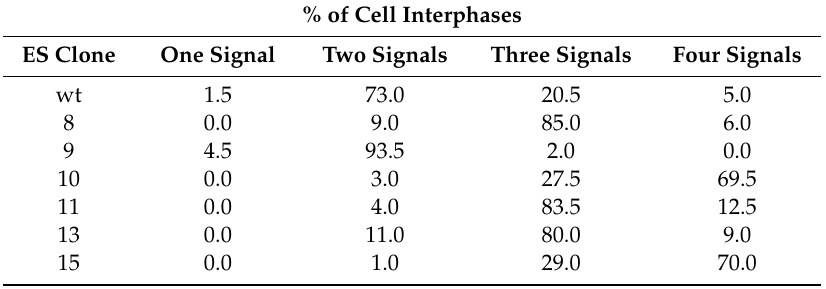
Table 1. Quantification of the FISH analysis performed in the ES cell clones. FISH was performed using the RPCI-23-362J7 BAC as a probe in wildtype (wt) ES cells and clones 8, 9, 10, 11, 13 and 15. The result is expressed as the percentage of interphases (two hundred analyzed) containing one, two, three or four signals.